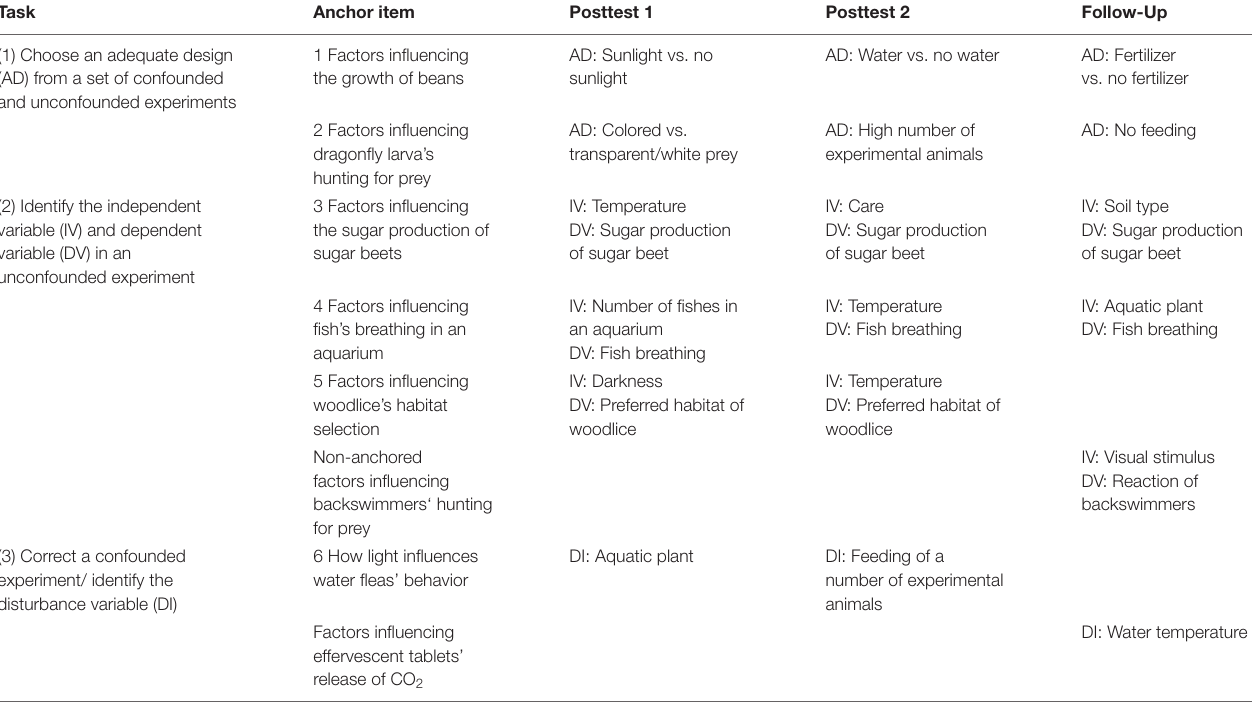
TABLE 1 | Anchor and non-anchored items of posttest 1, posttest 2, and follow-up. Task